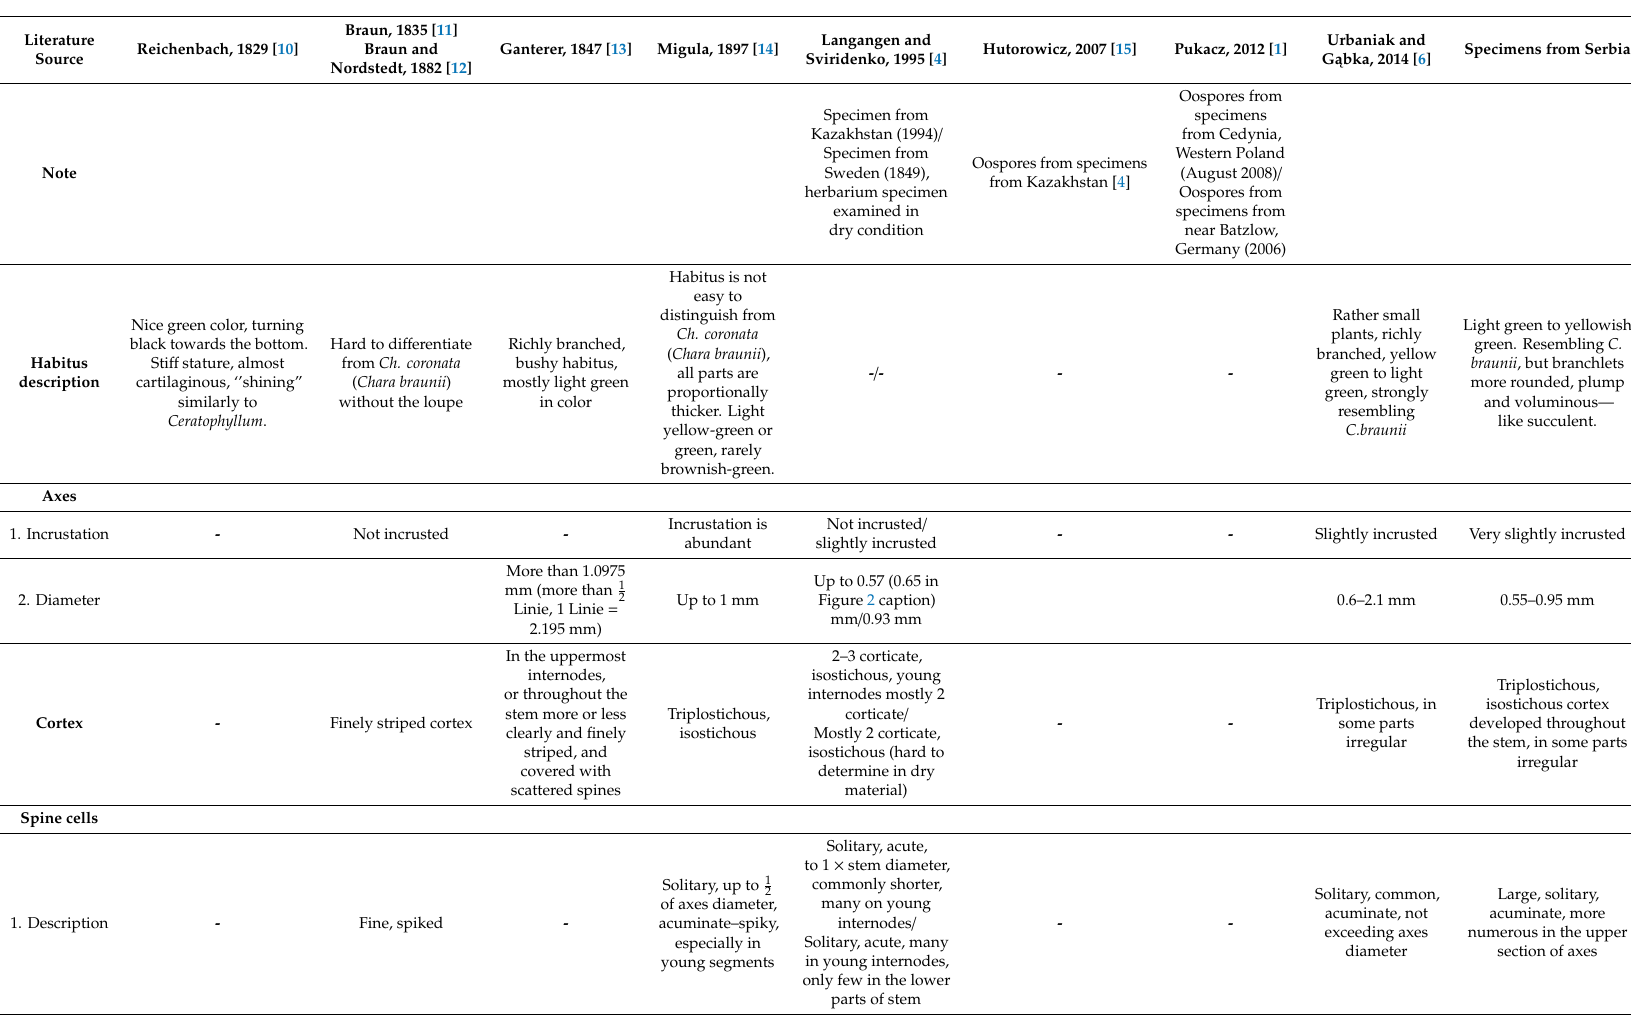
Table 2. Species traits of Chara baueri , as described in the literature, and traits measured in samples of C. baueri discovered in Serbia (19 specimens and 127 oospores were measured for obtaining presented values, measured material was previously conserved in